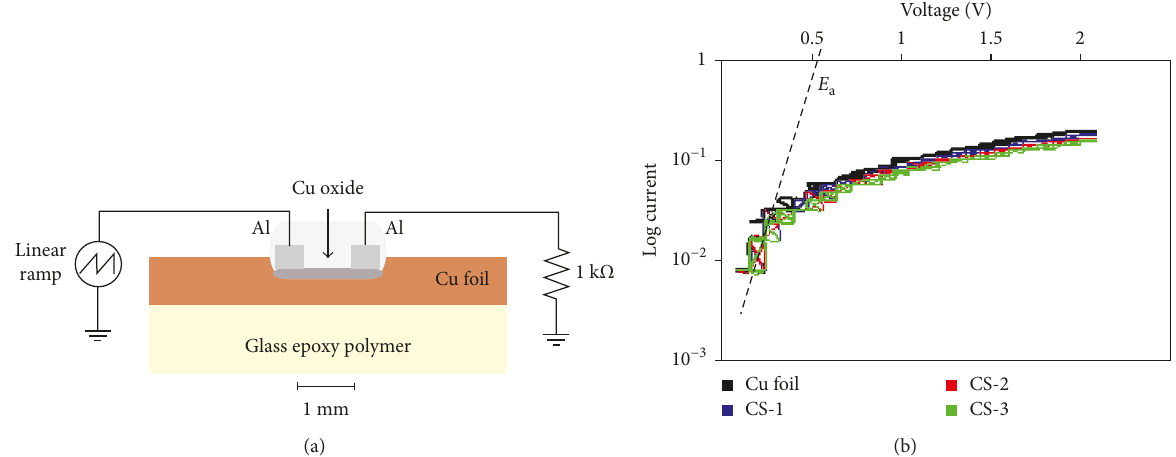
Figure 4: (a) Schematic diagram of practical circuit implemented to measure the current-voltage curves in Cu oxide samples. (b) Log current-voltage plots of each sample. Table 2: Conduction parameters in Cu oxide samples.